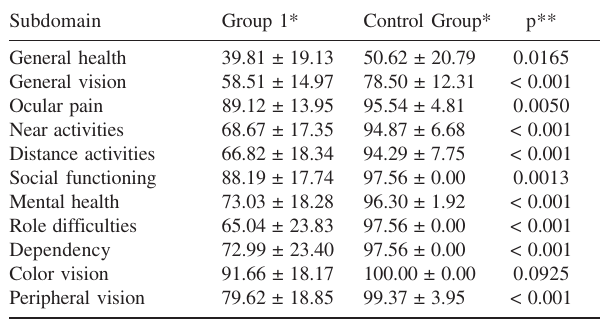
Table 2 - Comparison of the NEI VFQ – 25 subdomain scores based on the responses of patients with age-related macular degeneration and either monocular (group 1) or binocular (group 2) legal blindness at the University of Sao Paulo General Hospital in 2006